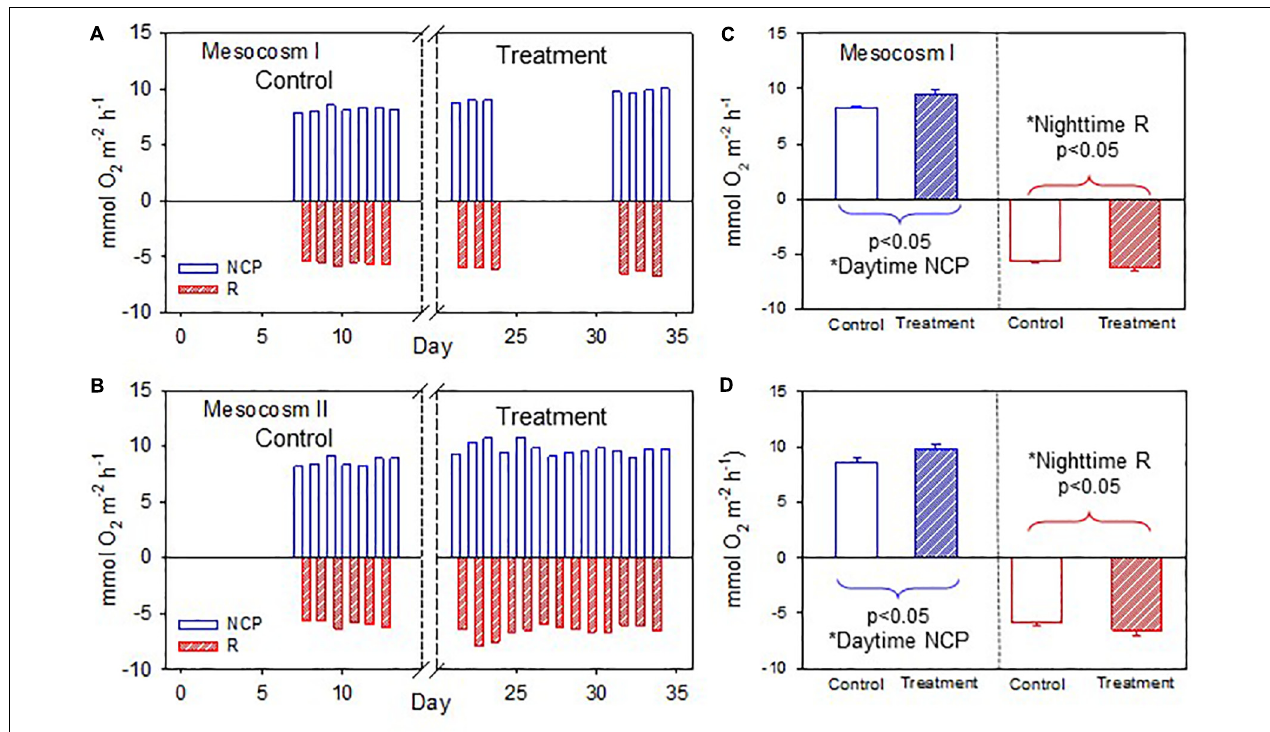
FIGURE 4 | (A,B) Temporal variations of daytime net community production (NCP) and nighttime respiration (R) in mesocosms I and II during the control and treatment periods. (C,D) Comparisons of average daytime NCP and nighttime R in mesocosms I and II between the control and treatment periods by the Student’s t -test. The asterisks indicate that the difference is statistically significant ( p -value <